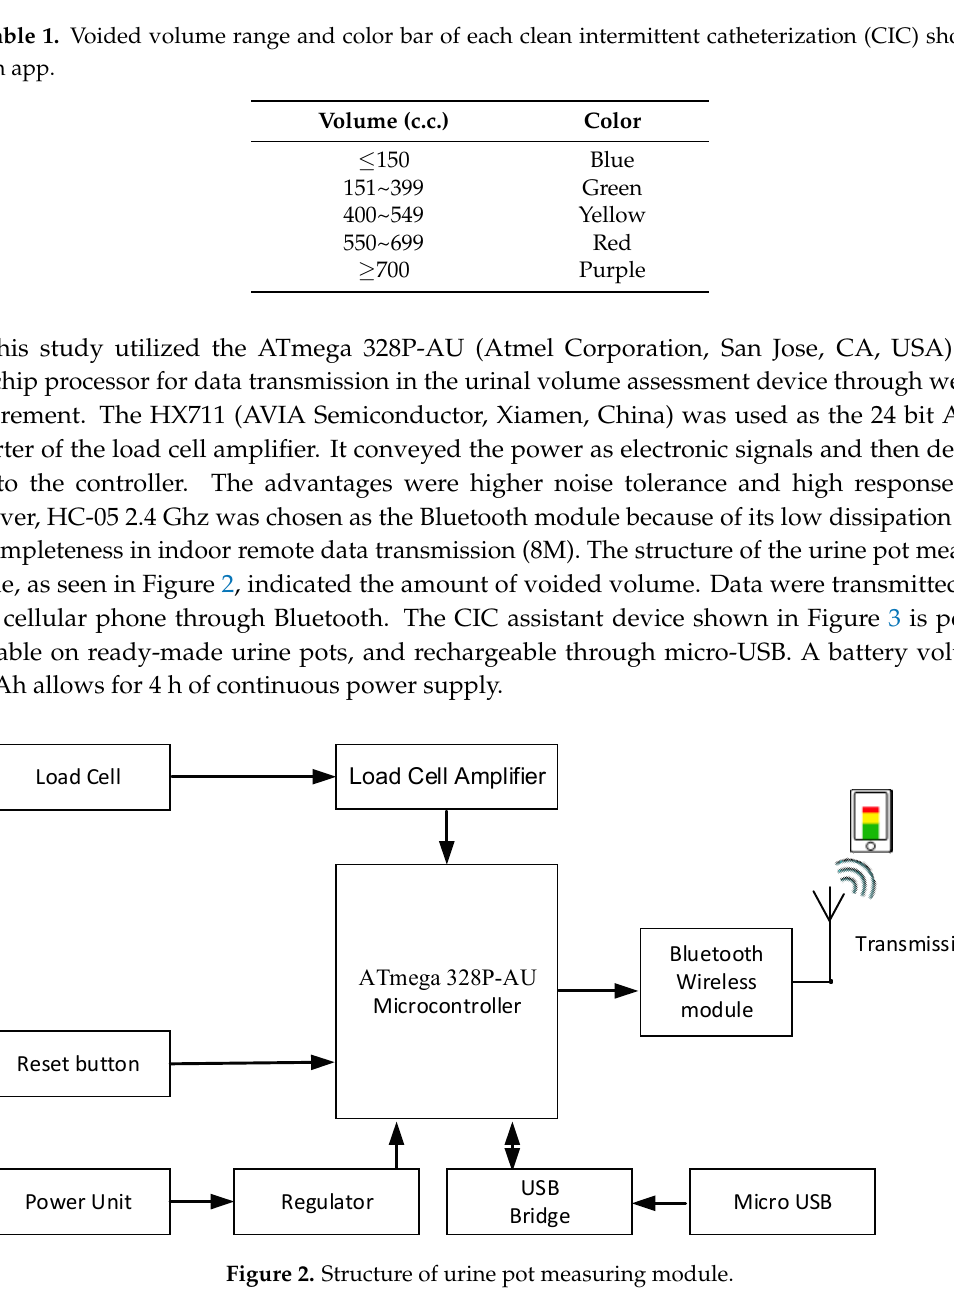
Table 1. Voided volume range and color bar of each clean intermittent catheterization (CIC) show on app.